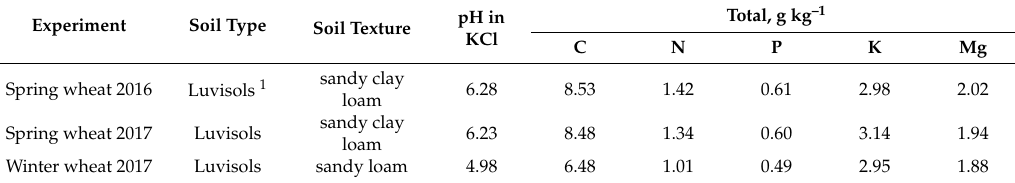
Table 2. Soil characteristics before the start of the